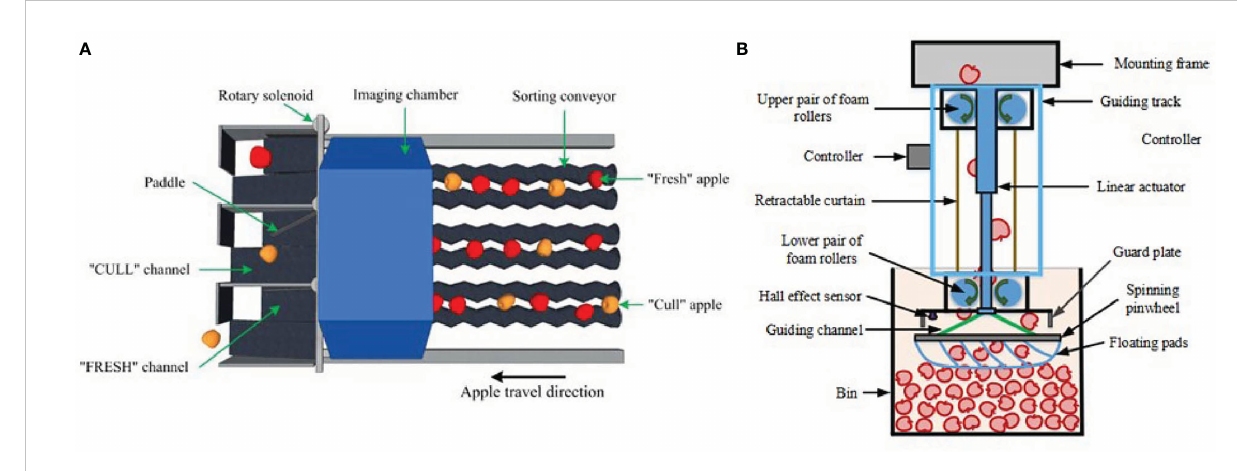
FIGURE 2 Schematic of a sorting machine: (A) image processing unit, fruit conveyor, and paddle; (B) bin fi ller (Lu et al., 2022).